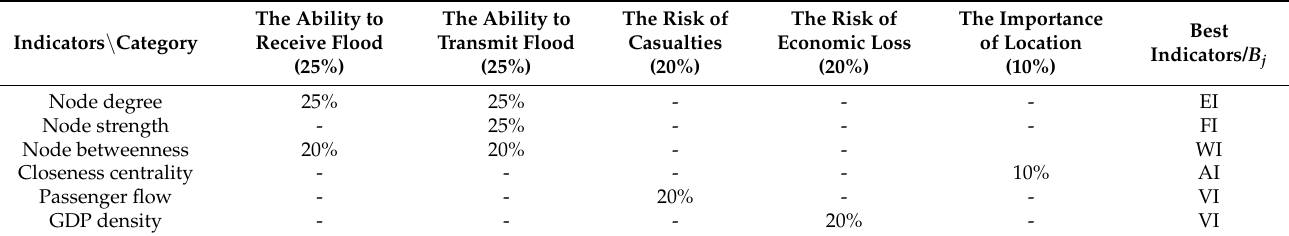
Table 4. The evaluation outcomes of the relative importance of the six indicators.